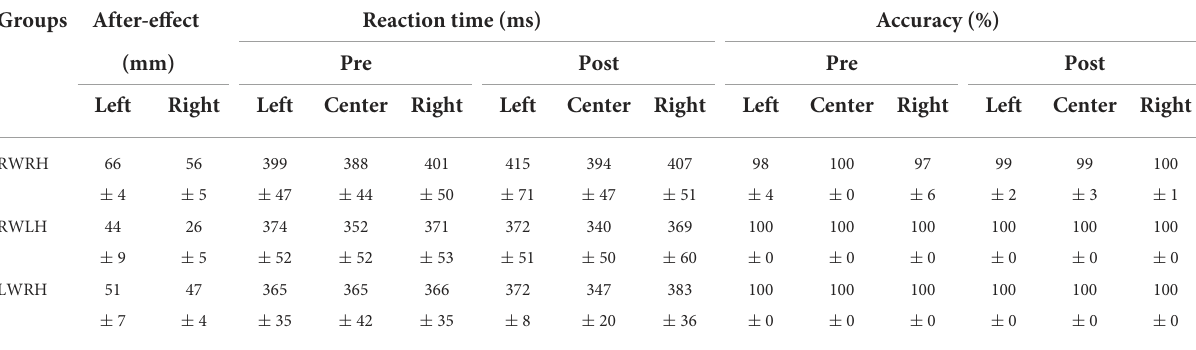
TABLE 1 Behavioral data for the RWRH, RWLH, and LWRH groups: averages and standard errors for the after-effect and the detection task. Groups After-effect Reaction time (ms) Accuracy (%) (mm) Pre Post Pre Post Left Right Left Center Right Left Center Right Left Center Right Left Center